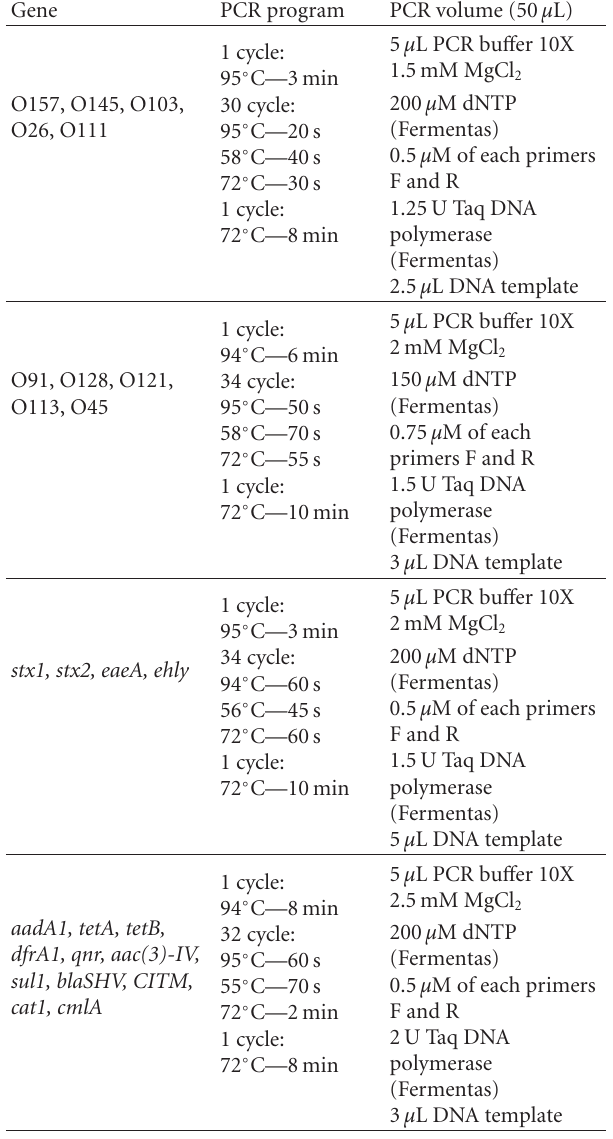
Table 4: PCR conditions for detection of serogroups, virulence genes and antimicrobial resistance genes in Shiga toxin-producing Escherichia coli in bovine mastitis.